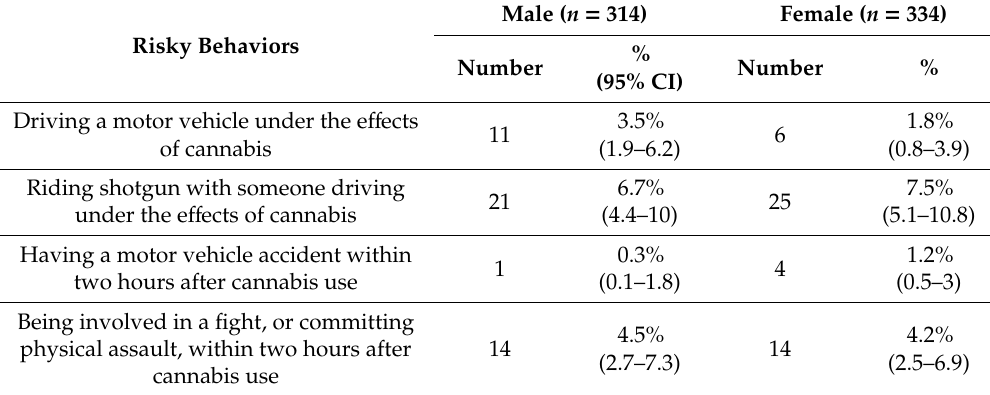
Table 3. Frequency of risky behaviors related to cannabis use for males and females.